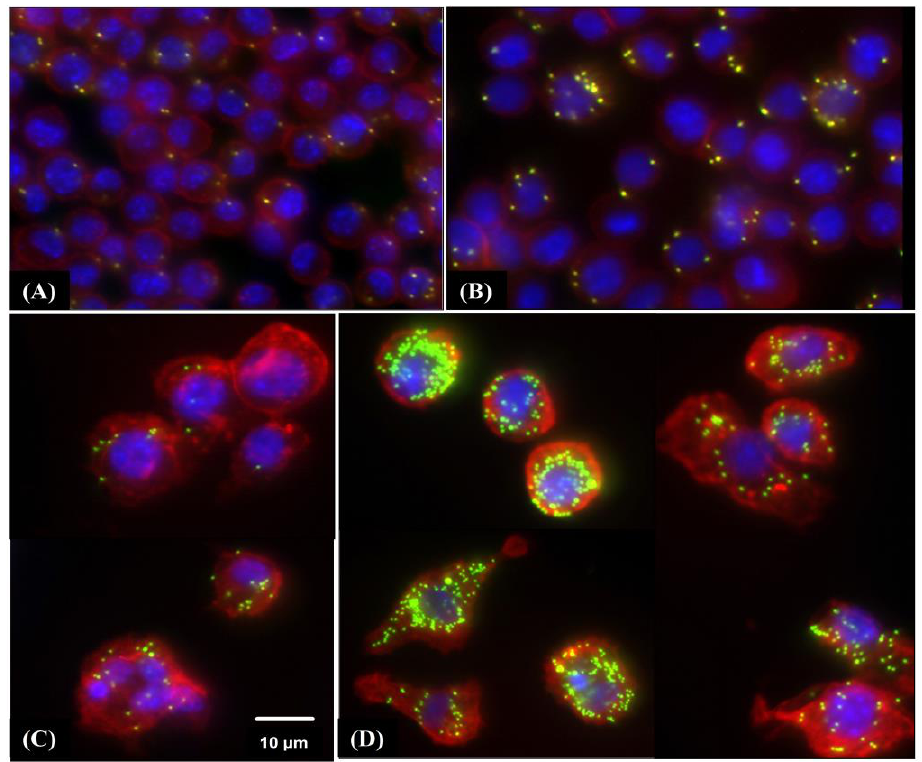
Figure 4. Immunofluorescence staining of RAW 264.7 macrophages stimulated by HW-Pm. Macrophages were incubated with HW-Pm (100 and 500 µ g/mL) and LPS (100 ng/mL) and IFN- γ (5 ng/mL), respectively. Carboxylate-modified polystyrene yellow–green fluorescent beads were added to the cells. Macrophages were fixed with 4% paraformaldehyde, permeabilized using 0.5% Triton X-100 and further stained with Texas Red ® -X phalloidin (Invitrogen TM , Waltham, MA, USA) to stain F-actin, and cell nuclei were visualized with 4′,6-diamidino-2-phenylindole (DAPI) under a fluorescence microscope. Representative images of each group (Scale bar 10 µm): ( A ) Control (DMEM), ( B ) LPS–IFN-γ, ( C ) HW-Pm 100 µg/mL and ( D ) HW-Pm 500 µg/mL.